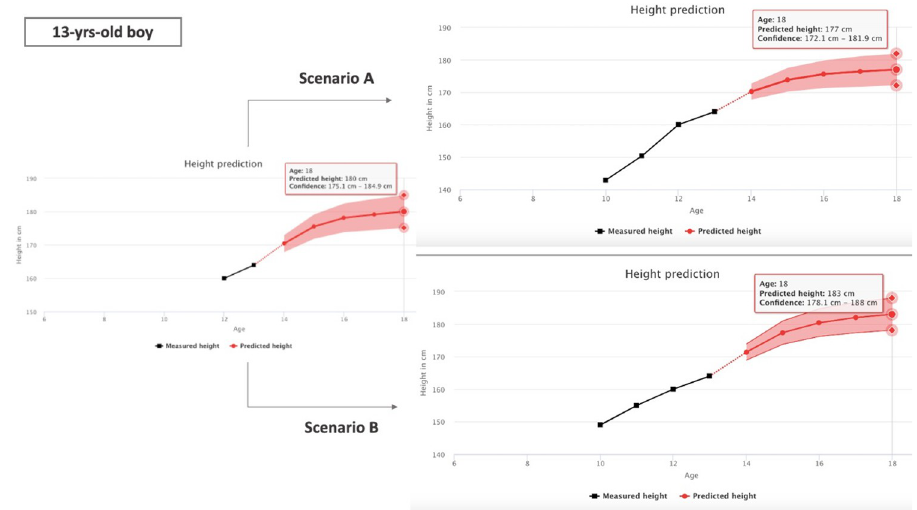
Fig 4. A demonstration of the application performance–measured heights of a 13-year-old boy of average height, together with the height forecast for each specific year by the age of 18, with 95% confidence interval marked. The left panel shows a forecast based on the minimal number of measurements (i.e., two), while the right panel shows 2 forecasts based on a longer time series (i.e., 4 years). Scenario A assumes that the PHV occurred at age 12, while scenario B assumes that the PHV has not yet occurred.